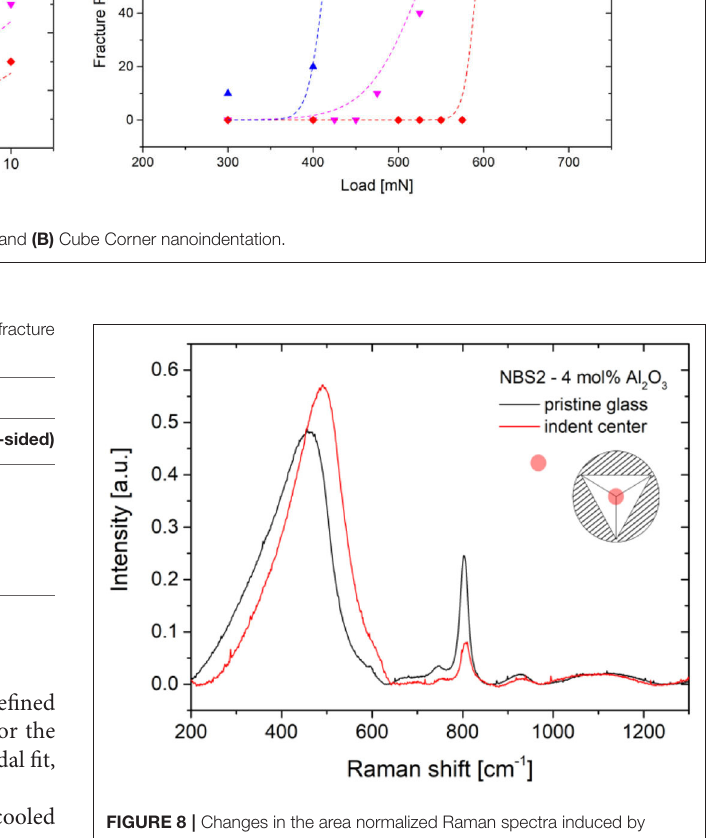
FIGURE 8 | Changes in the area normalized Raman spectra induced by indentation in furnace cooled NBS2 glass (4 mol% Al 2 O 3 ). The black curve represents the pristine condition while the red curve is measured at indent